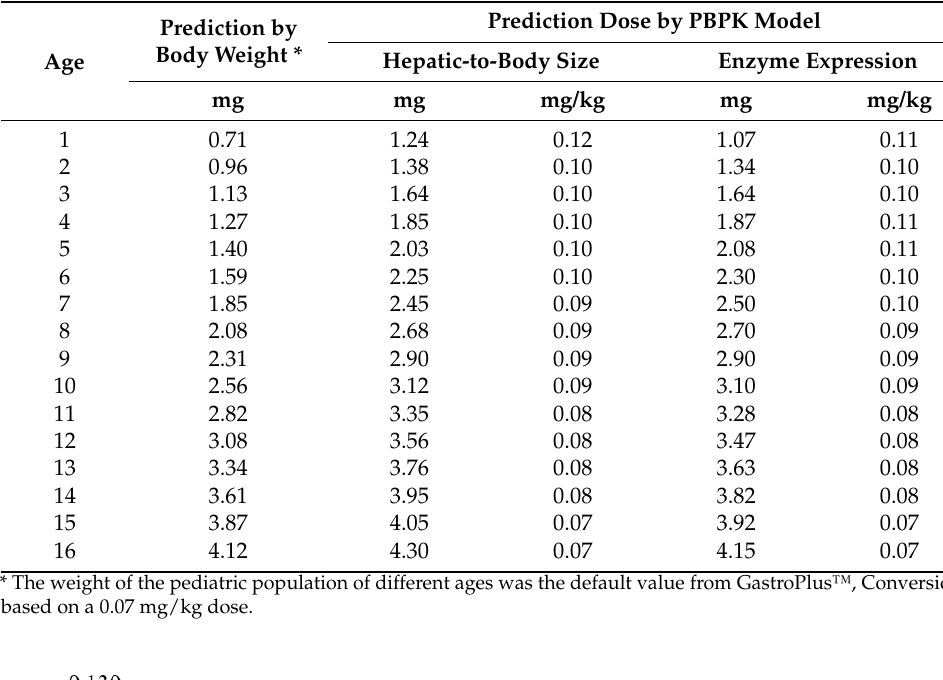
Table 4. Dosage derivation of amlodipine administered orally in a Chinese pediatric population.